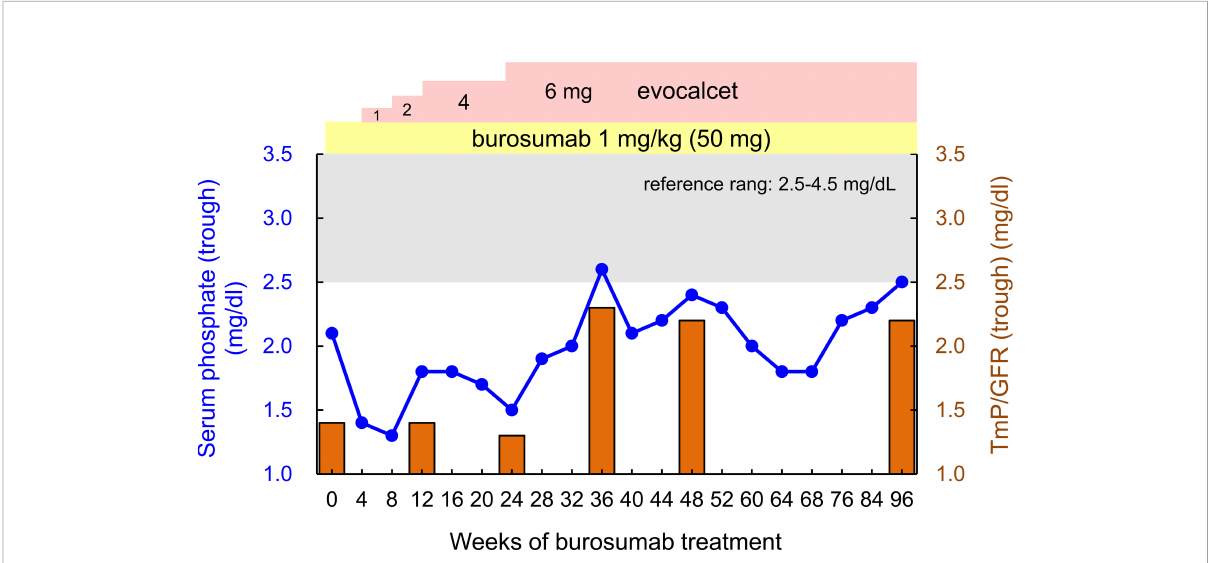
FIGURE 2 Changes in the trough (end of the dosing interval) serum phosphate levels (blue line) and TmP/GFR (orange bar) over 96 weeks of burosumab treatment. The gray zone in the panel indicates values within reference range (2.5-4.5 mg/dL), and the yellow and pink zones indicate the doses of burosumab and evocalcet,